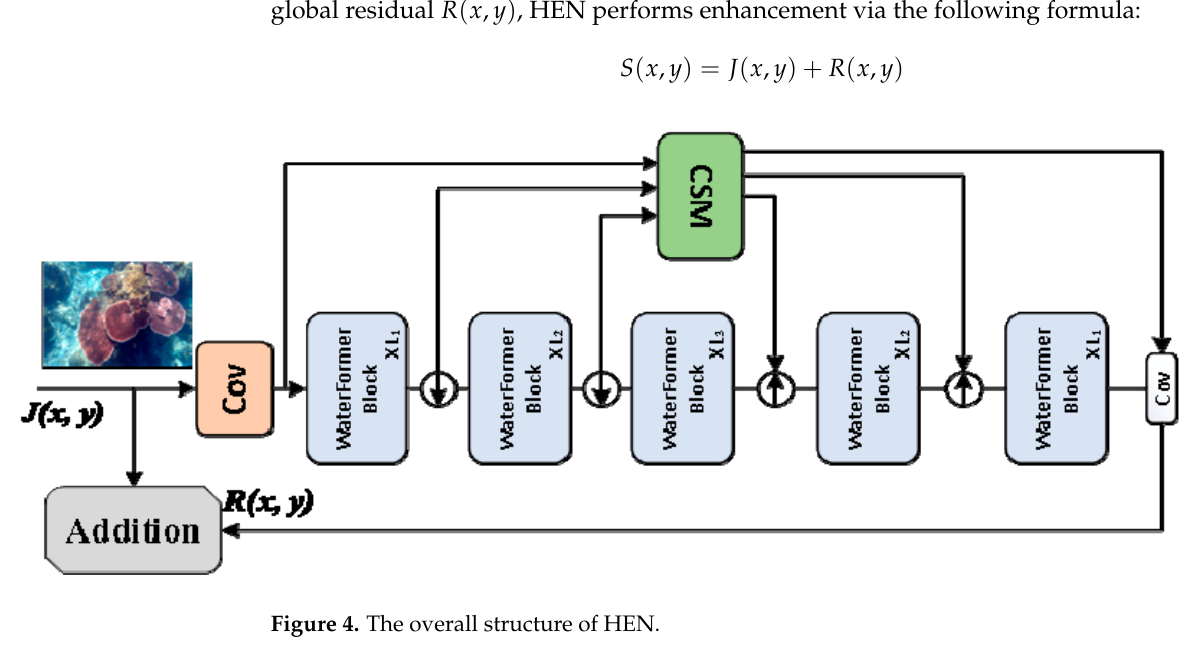
( b ) Figure 5. Structure in WaterFormer block. ( a ) Structure of LIMP module, ( b ) structure of the Water- Former Block. To cut down the computational cost of self-a tt ention operation, we introduced shifted window self-a tt ention (SWSA), which was applied in SwinTransformer [17]. SWSA di- vides an image into several patches and computes self-a tt ention operation within each patch. Then, the shifted window scheme is used to fuse the results of each patch. It can be proven that SWSA can compute self-a tt ention at a linear cost [17]. Previous research found that the MLP layer in Transformer has a limited ability to learn the local context [18]. However, UIE images are characteristic of having similar dis- tortion features in adjacent areas, which means the lack of gathering local information can cause the model to perform badly. Therefore, it is necessary to add local a tt ention to our model considering that adjacent pixels are an important reference for reconstructing a distorted underwater image. We substituted the regular MLP in the Transformer structure for our proposed LIMP and added LIMP as a parallel module to WaterFormer Block. As shown in Figure 5, LIMP relies on three di ff erent sizes of convolution kernel ( 1 1 × , 3 3 × and 5 5 ×